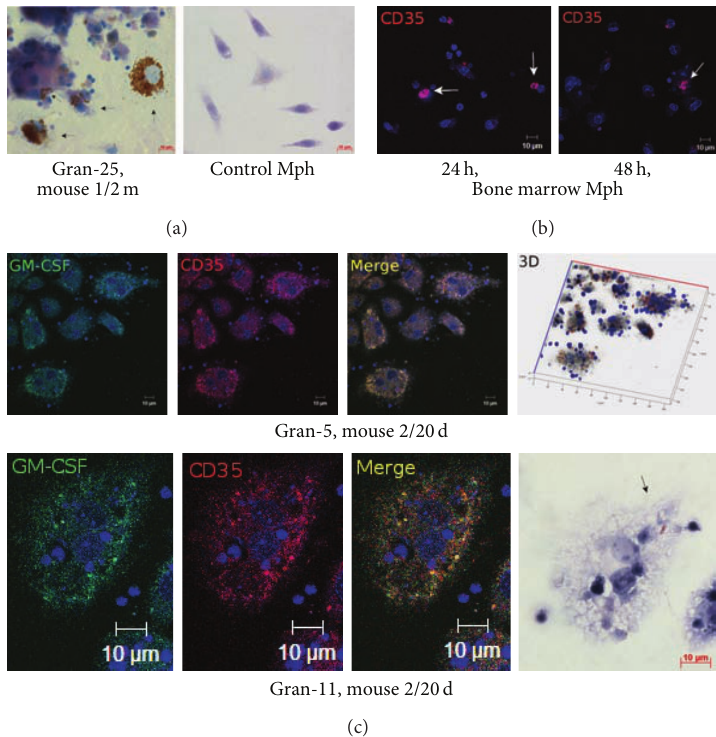
Figure 10: The phagocytic receptor CD35 on the cells in the fragments of mouse splenic granulomas. The scale bars are 10 𝜇 m each. ((b)- (c)) Nuclei stained by DAPI (blue signal). (a) Immunochemical localization of CD35 on granuloma cells and control mouse peritoneal macrophages (Mph). The brown color indicates the presence of the receptor in these cells. The black arrows indicate macrophages stained for this marker. (b) Confocal immunofluorescent localization of CD35 (red signal) on the cells in the cultures of bone marrow macrophages following infection with BCG in vitro and after culture for several hours. Macrophages stained for CD35 are indicated by the white arrows. (c) Confocal immunofluorescent localization of GM-CSF (green signal) and CD35 (red signal) in granuloma macrophages. In the lower-right panel, the same fragment as in the other panels restained for acid-fast BCG-mycobacteria by the ZN method. The black arrow on the ZN image indicates the macrophage region with BCG-mycobacteria reproducing in it. Abbreviations as in Figure